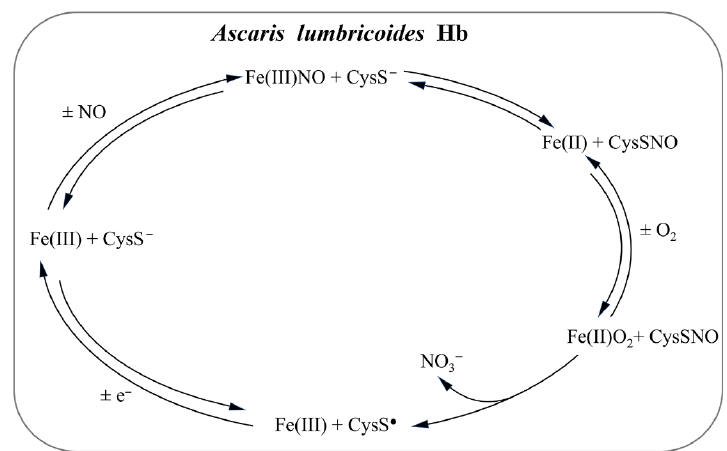
Figure 5. NO detoxification mediated by A. lumbricoides Hb.